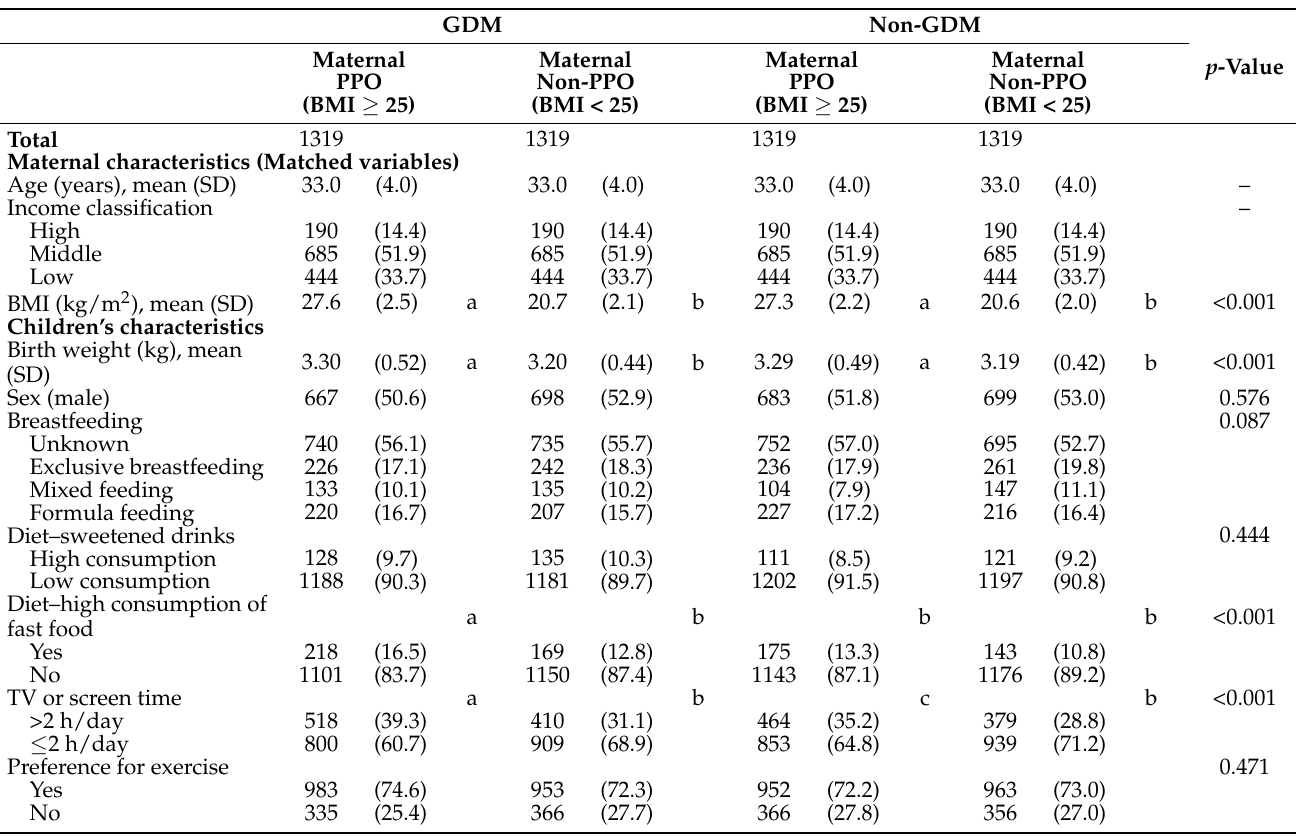
Table 1. Baseline